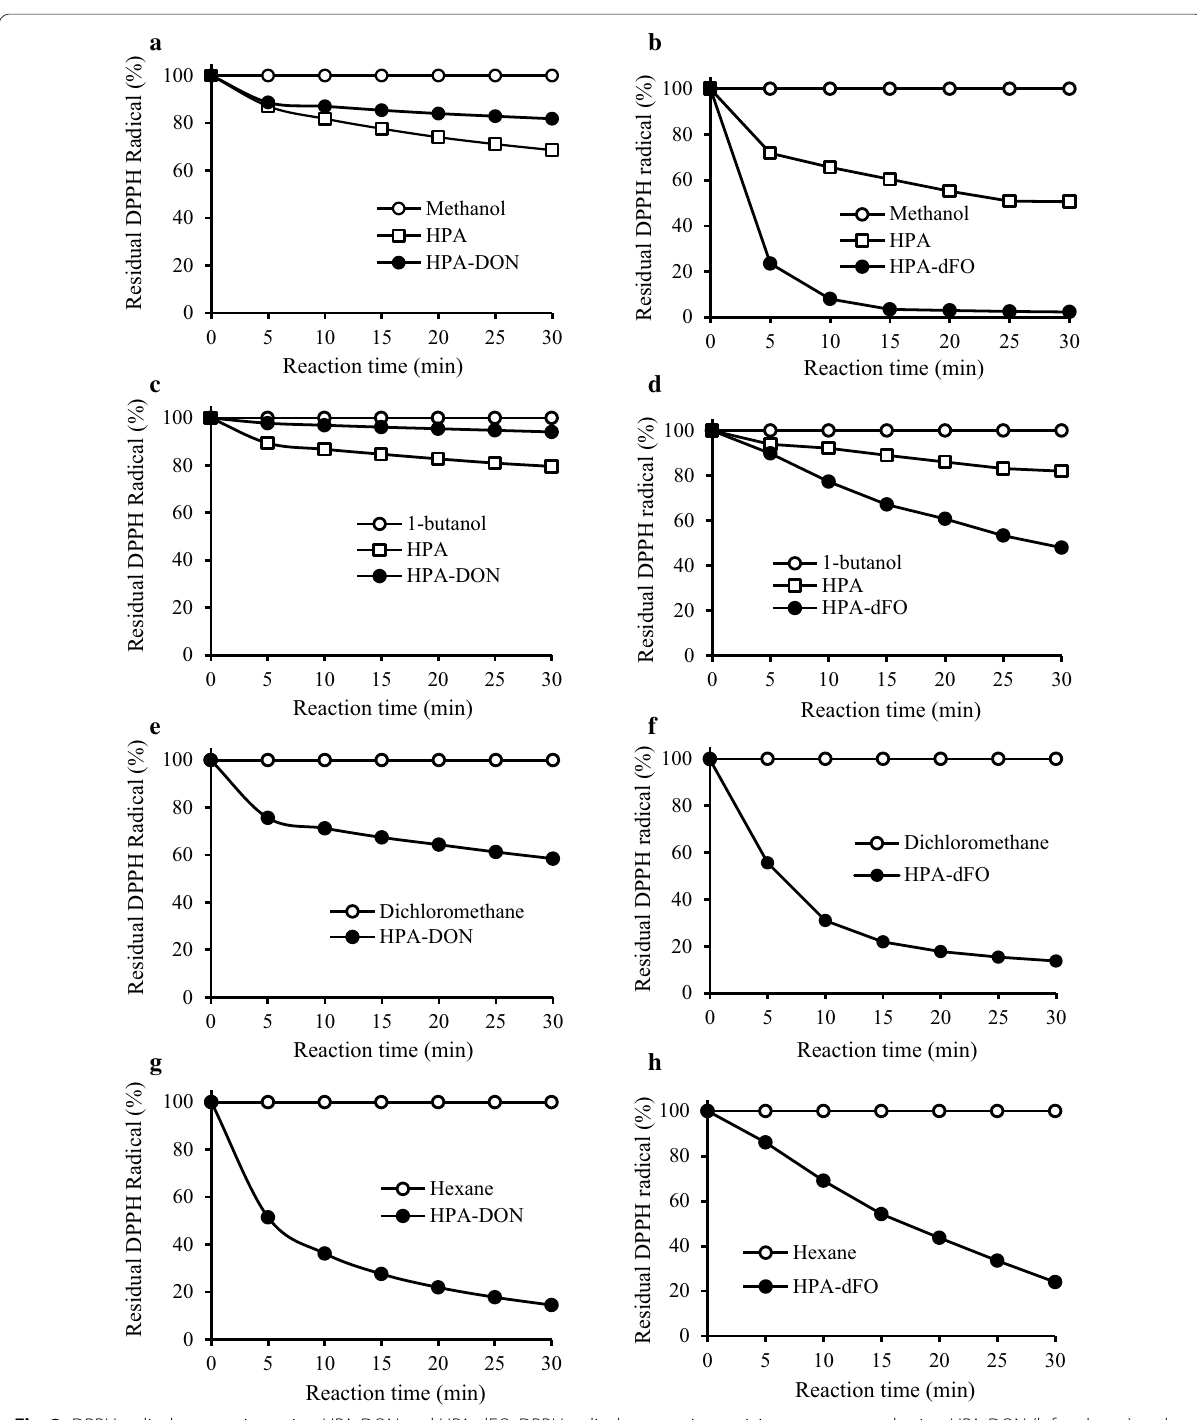
Fig. 3 DPPH radical scavenging using HPA-DON and HPA-dFO. DPPH radical scavenging activity was measured using HPA-DON (left column) and HPA-dFO (right column). Assay was performed in a and b methanol, c and d 1-butanol, e and f dichloromethane, and g and h hexane systems, using each solvent, ( ○ ), 10 mM HPA ( □ ), and 10 mM HPA-DON (or HPA-dFO) ( ●